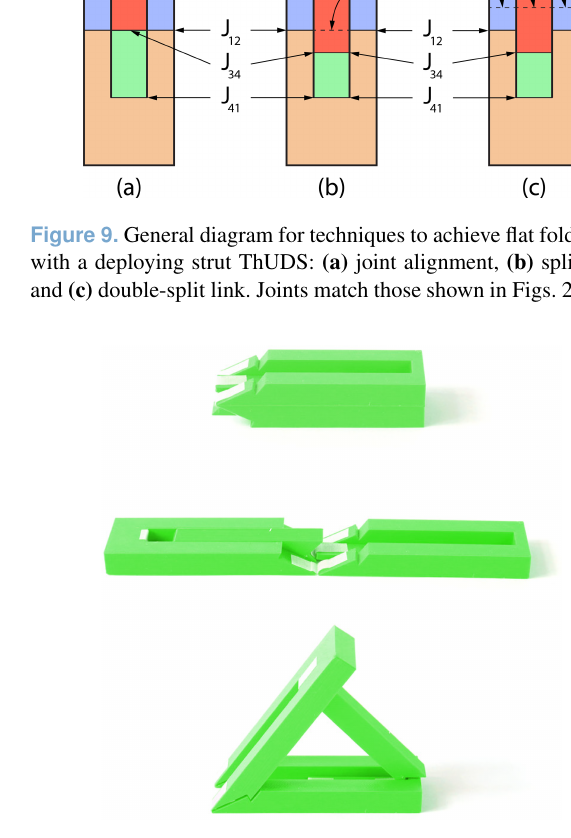
Figure 10. Flat-foldable planar deploying strut ThUDS with in- creased surface contact to improve load carrying. Shown in flat- folded, flat, and deployed